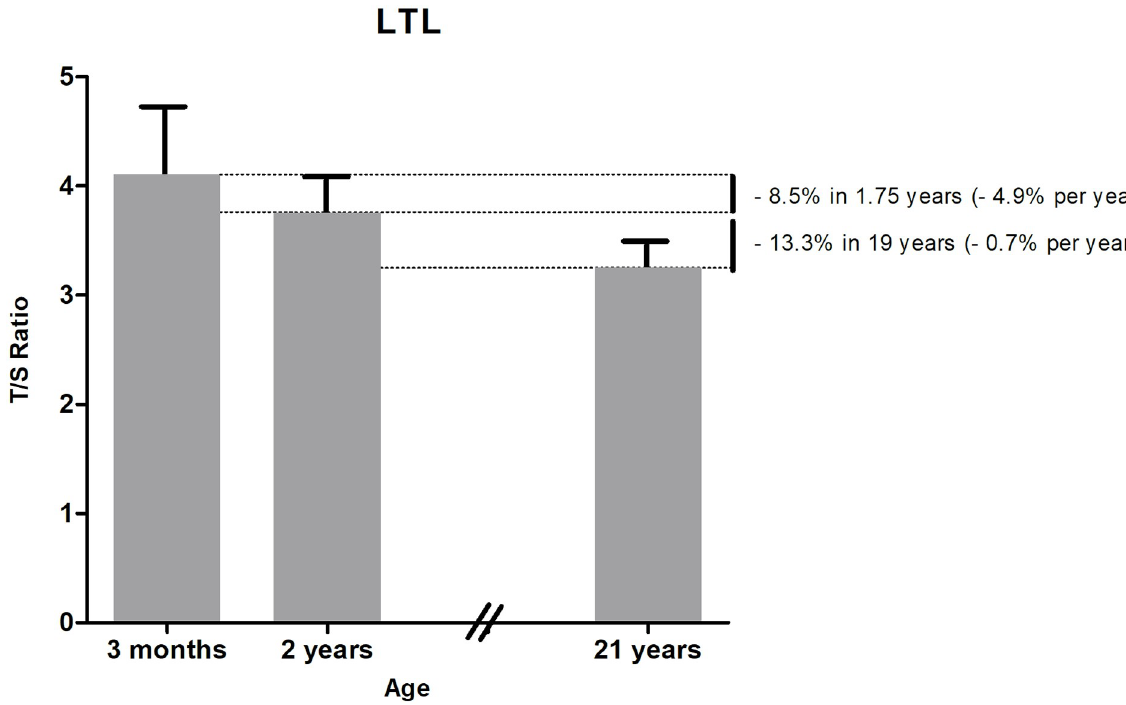
Fig 1. Longitudinal LTL development over time based on outcome of two separate birth cohort studies. Data are expressed as median LTL at 3 months and 2 years (current study) and mean LTL at 21 years (from our previous PROGRAM study [18]), both with upper interquartile